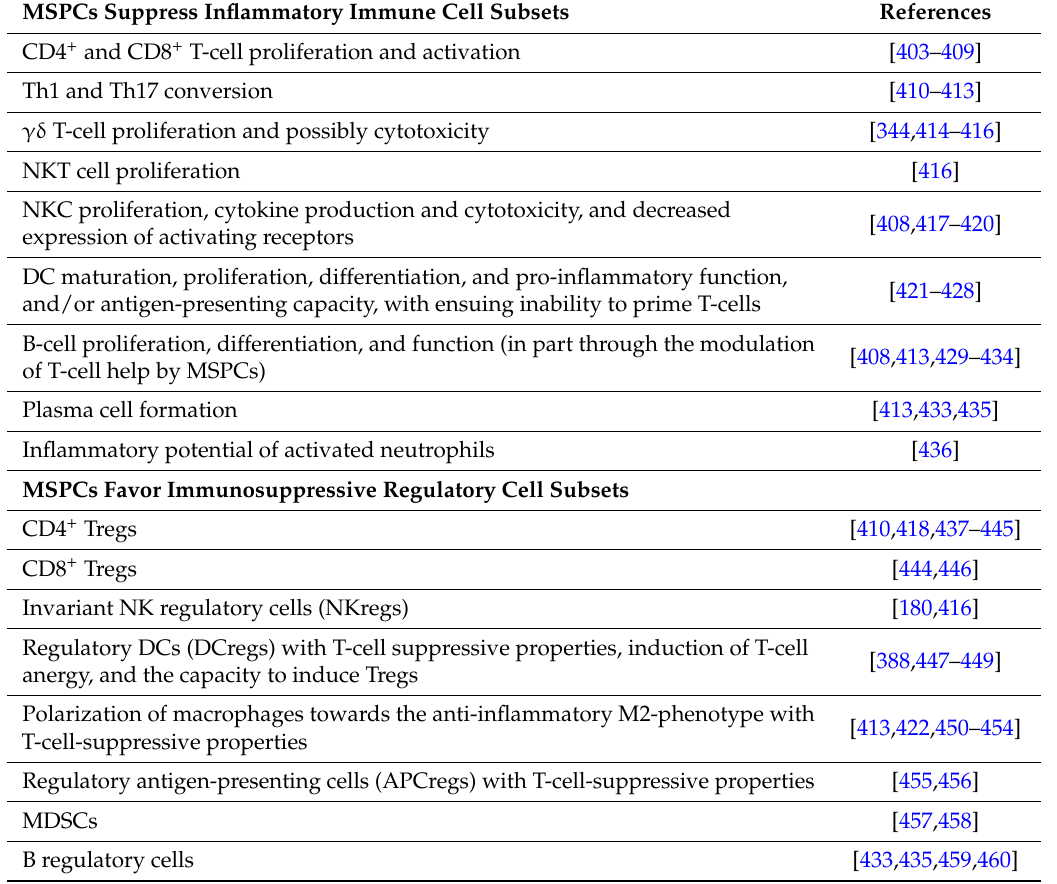
Table 2. MSPC-mediated modulation of the immune